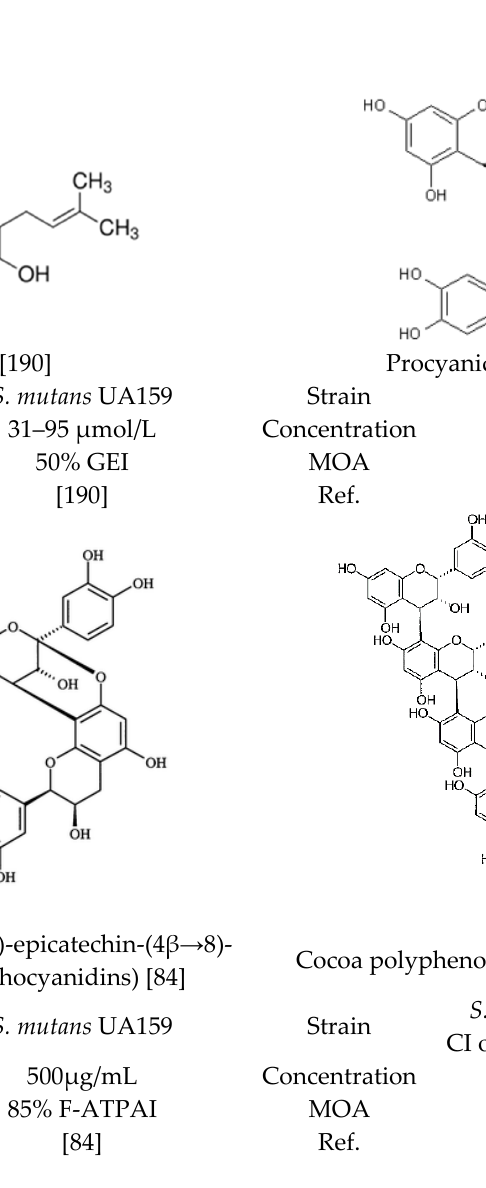
Figure 2. Chemical structure of polyphenols with inhibition activity against F-ATPase, glycolytic enzymes and glycolytic pH-drop. Abbreviations: CI; Clinical Isolate, F-ATPAI; F-ATPase Activity Inhibition, GEI; Glycolytic Enzymes Inhibition, GpHDI; Glycolytic pH-Drop Inhibition, MOA; Mode of Action, Ref.; References .